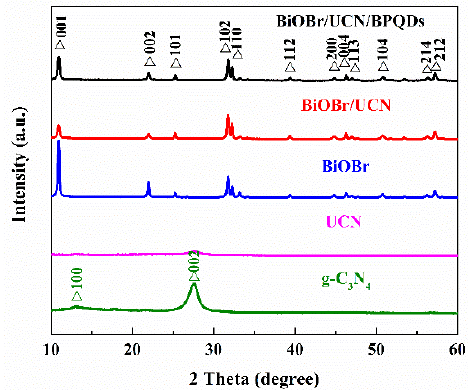
Figure 3. XRD of pure g-C 3 N 4 , UCN, pure BiOBr, BiOBr/UCN, and BiOBr/UCN/BPQDs.